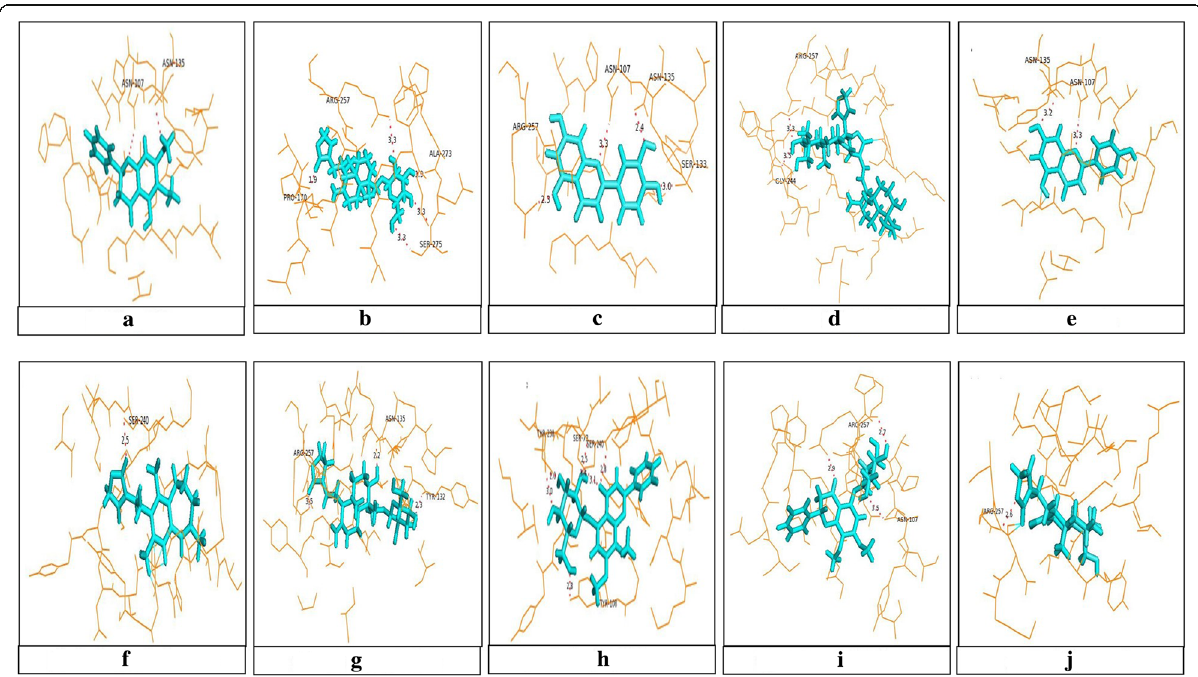
Fig. 1 Molecular docking of CTX-M-15 with 10 different bioactive compounds from A. paniculata. a Onysilin, b Neoandrographolide, c Luteolin, d